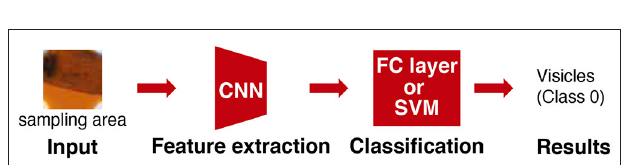
FIGURE 5 | An overview of the classification process of the TAIM method. The magnification of the slide images was 40x.